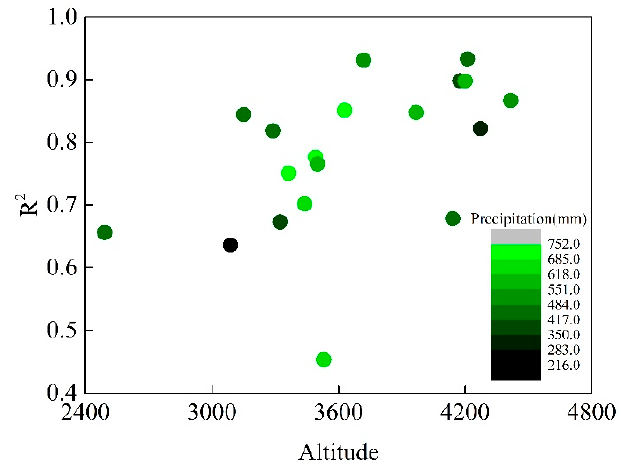
Figure 8. Scatter diagram for the relationship of precipitation with altitude and prediction accuracy R 2.